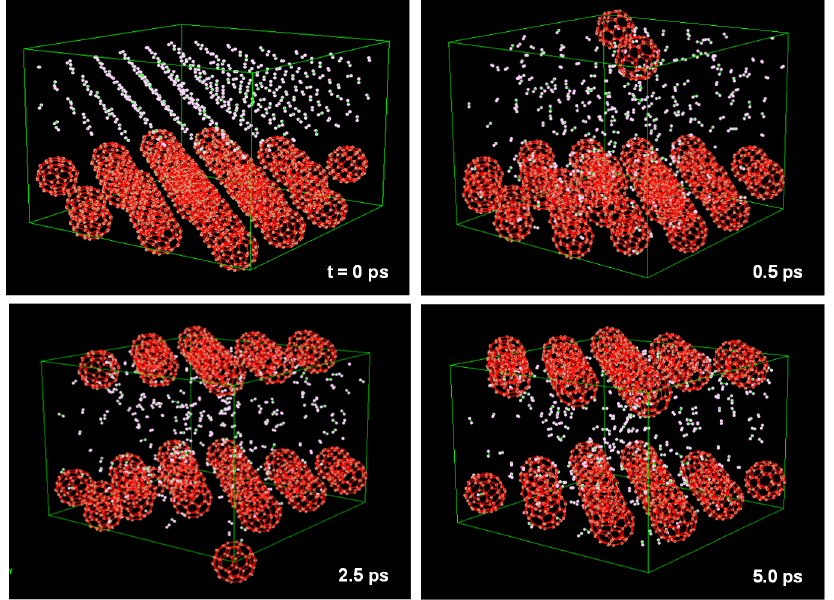
Figure 12. Molecular dynamics calculation to find condition of H 2 gas storage. Unit cell is composed from 32 C 60 ( fcc ) with 288 H 2 molecules ( fcc ). NPH ensembles and organic potential were used in the